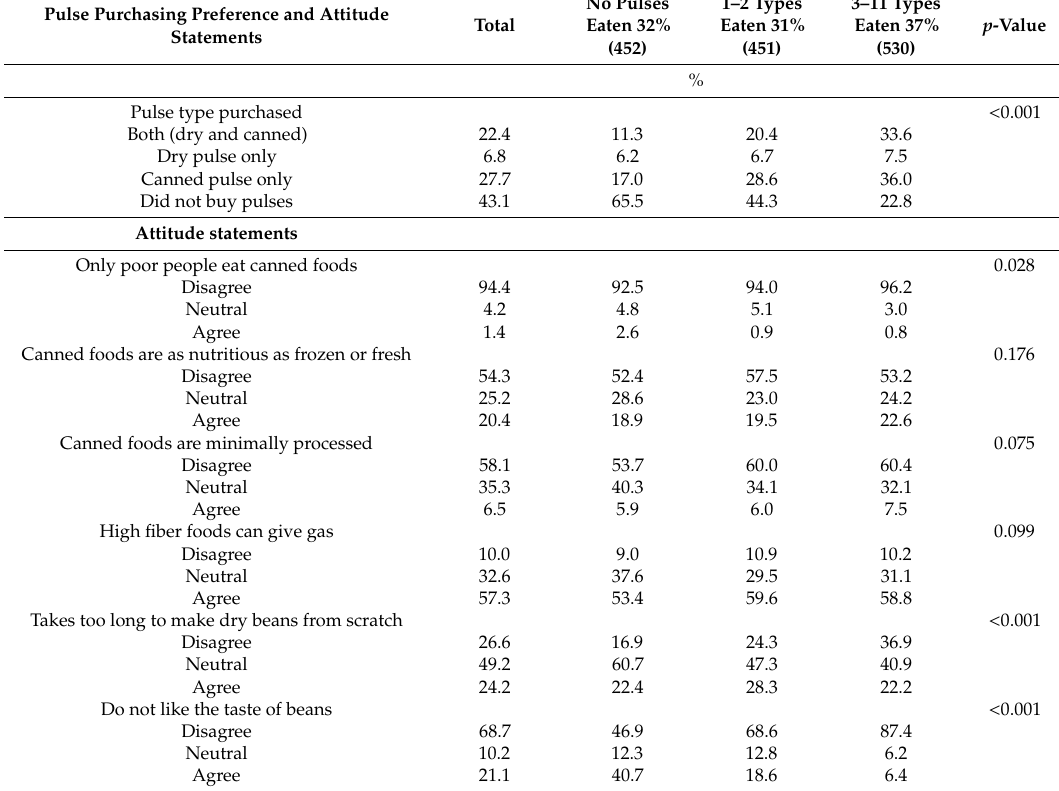
Table 3. Pulse purchasing patterns and attitudes of students enrolled at a Midwestern US university by trivariate pulse type count eaten per month (%; n =